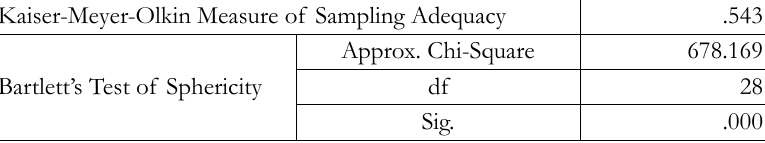
Table 2. ΚΜΟ and Bartlett’s test